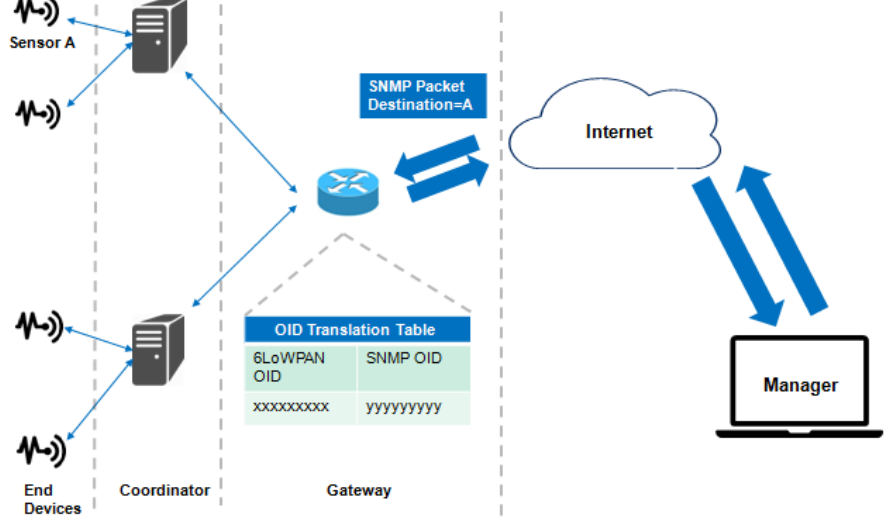
Figure 12. Illustration device level monitoring procedure for LNMP